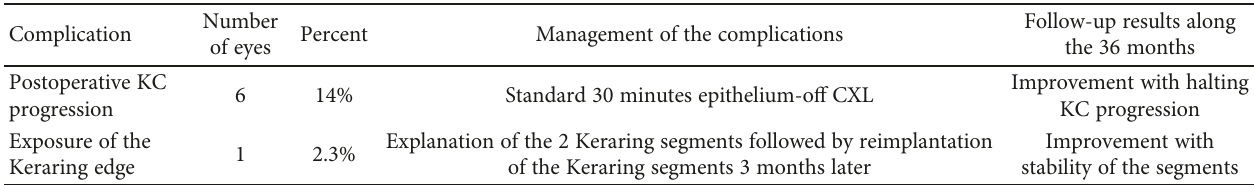
Table 6: The summary of